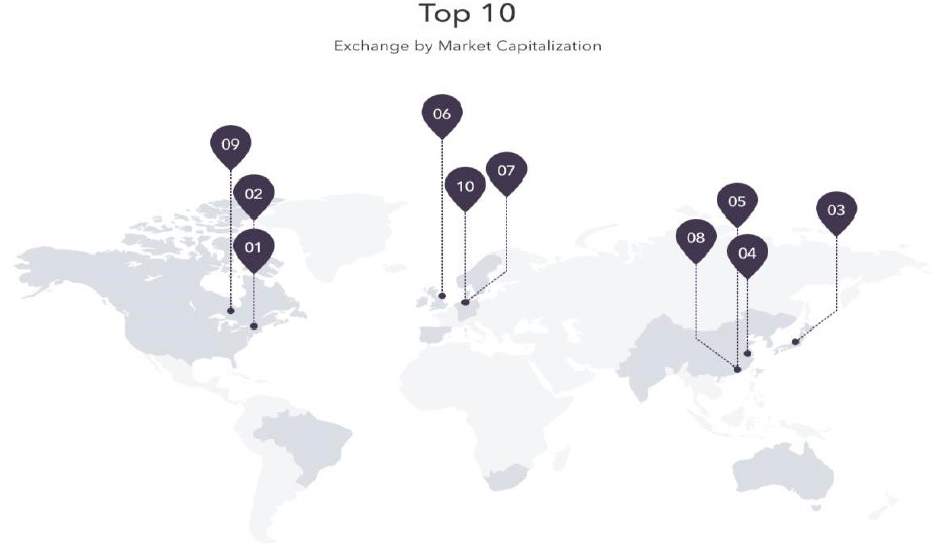
Figure 1. World top stock exchange by market capitalization. Source: Bloomberg (2018b) and Value Walk (2018).